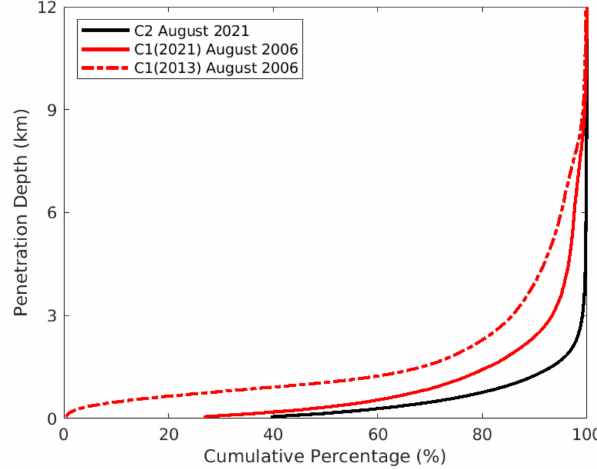
Figure 4. Penetration depths (minimum heights above ground level) of C1 in August 2006 (red) and C2 in August 2021 (black). The dashed red curve is C1 with 2013 processing, while the solid red curve is C1 with 2021 processing.